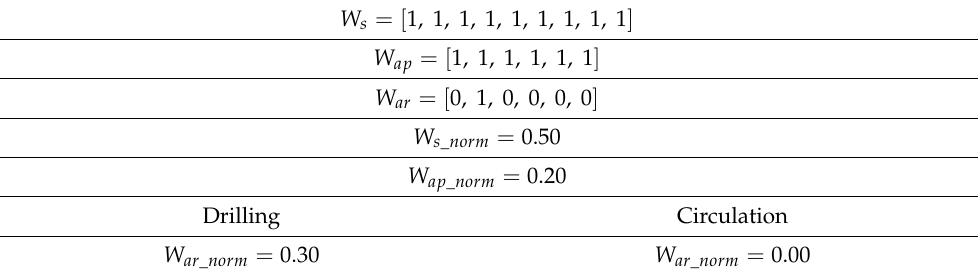
Table 5. Weight assignments for reward function shaping.